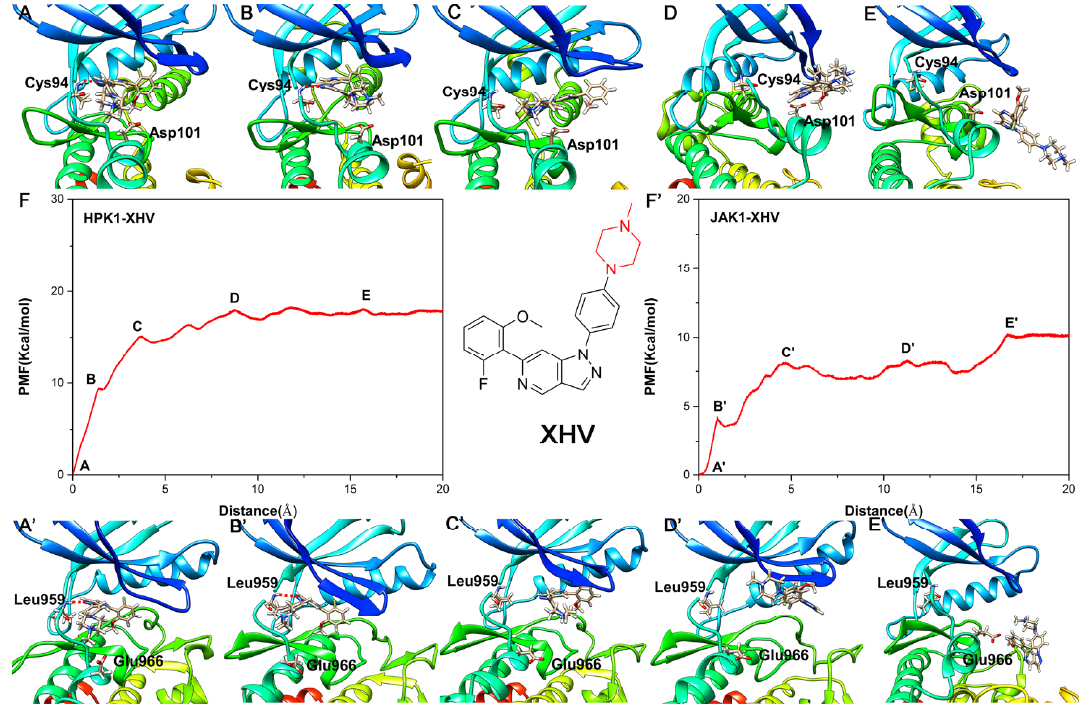
Figure 8. The unbinding process of inhibitor XHV dissociating from binding pocket of HPK1 kinase ( A – E ) and the corresponding PMF curve ( F ), the unbinding process of inhibitor XHV dissociating from binding pocket of JAK1 kinase ( A ’– E ’) and the corresponding PMF curve ( F ’).